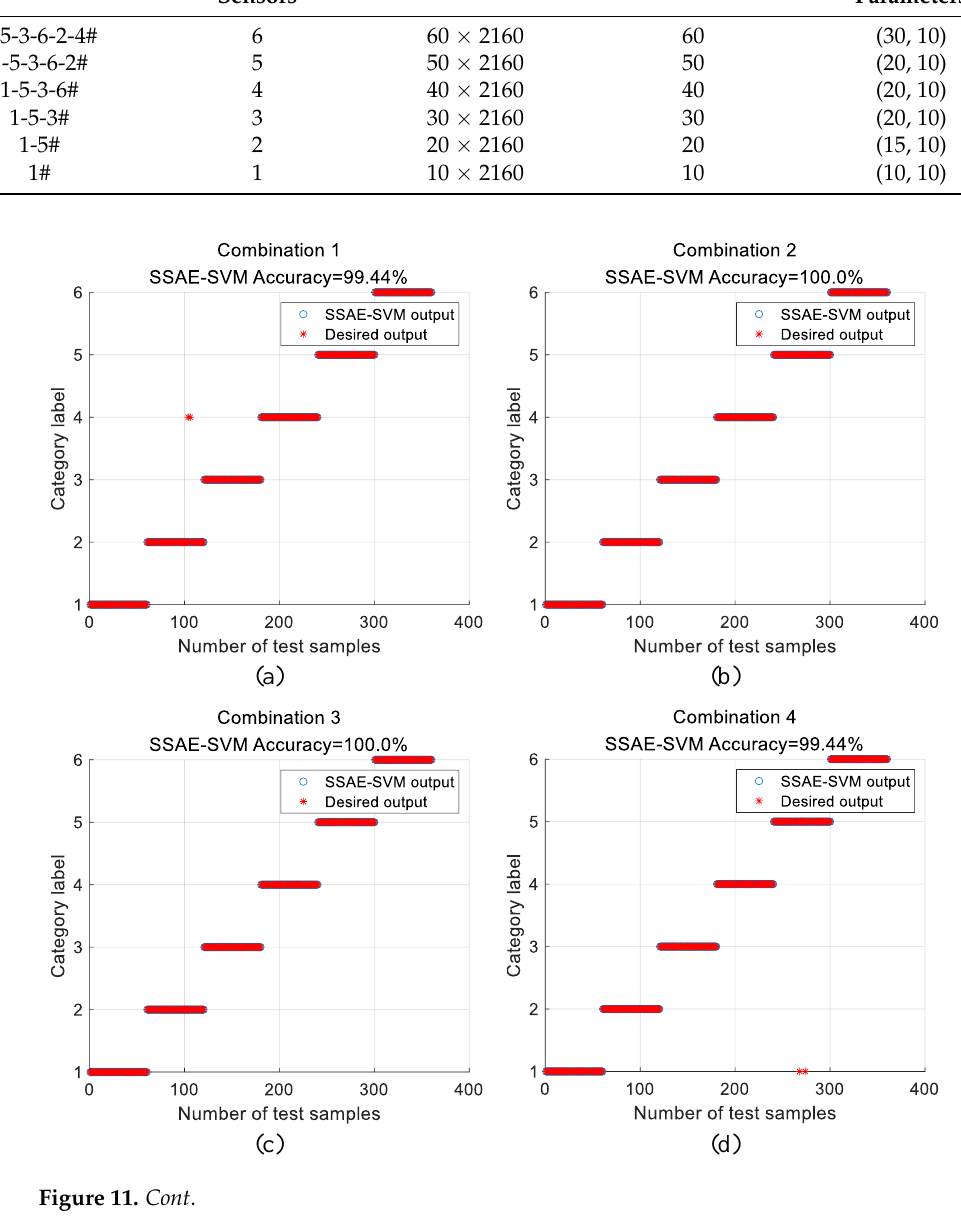
Figure 11. The SSAE-SVM diagnosis results under different sensor combinations: ( a ) Combination 1; ( b ) Combination 2; ( c ) Combination 3; ( d ) Combination 4; ( e ) Combination 5; ( f ) Combination 6. 4.6. The Comparative Analysis of the Classification Methods To further verify the effectiveness of the SSAE-SVM fault diagnosis method proposed in the manuscript, the data set of feature parameter Combination 6 (common features + frequency domain features) in Section 4.3 was utilized and chosen to form a 40 × 2160 feature matrix for verification, according to Combination 3, the optimal combination of sensors in the previous section. After the fusion of the SSAE method, the main parameter settings of the SSAE were the same as those of the SSAE parameter settings in Section 4.4.